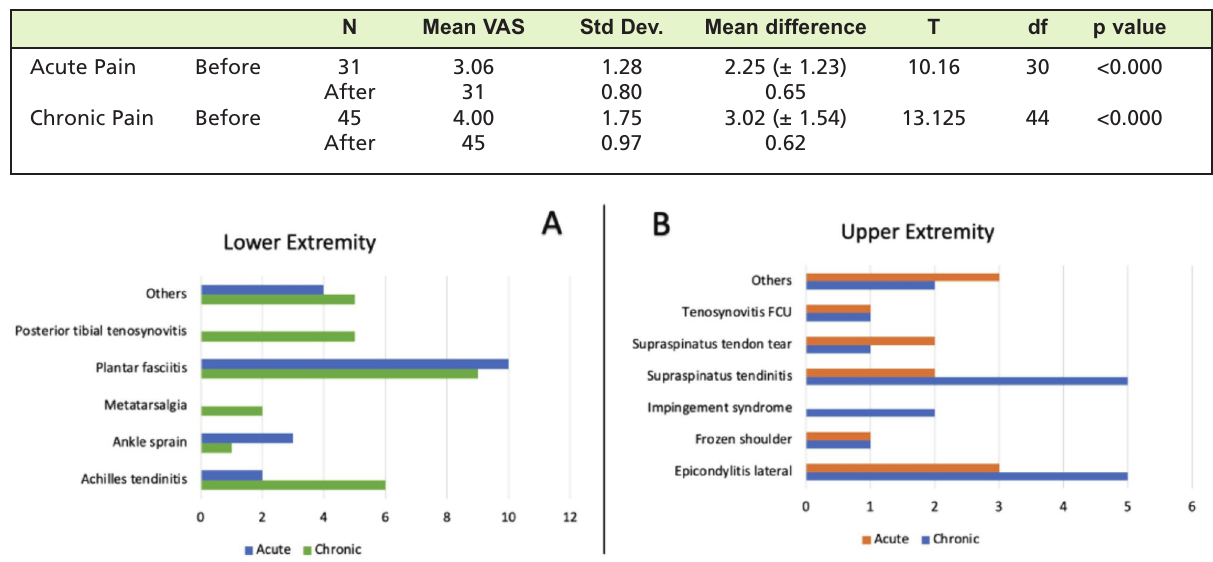
Paired T-Test evaluating the significance of PRP injection Table III: